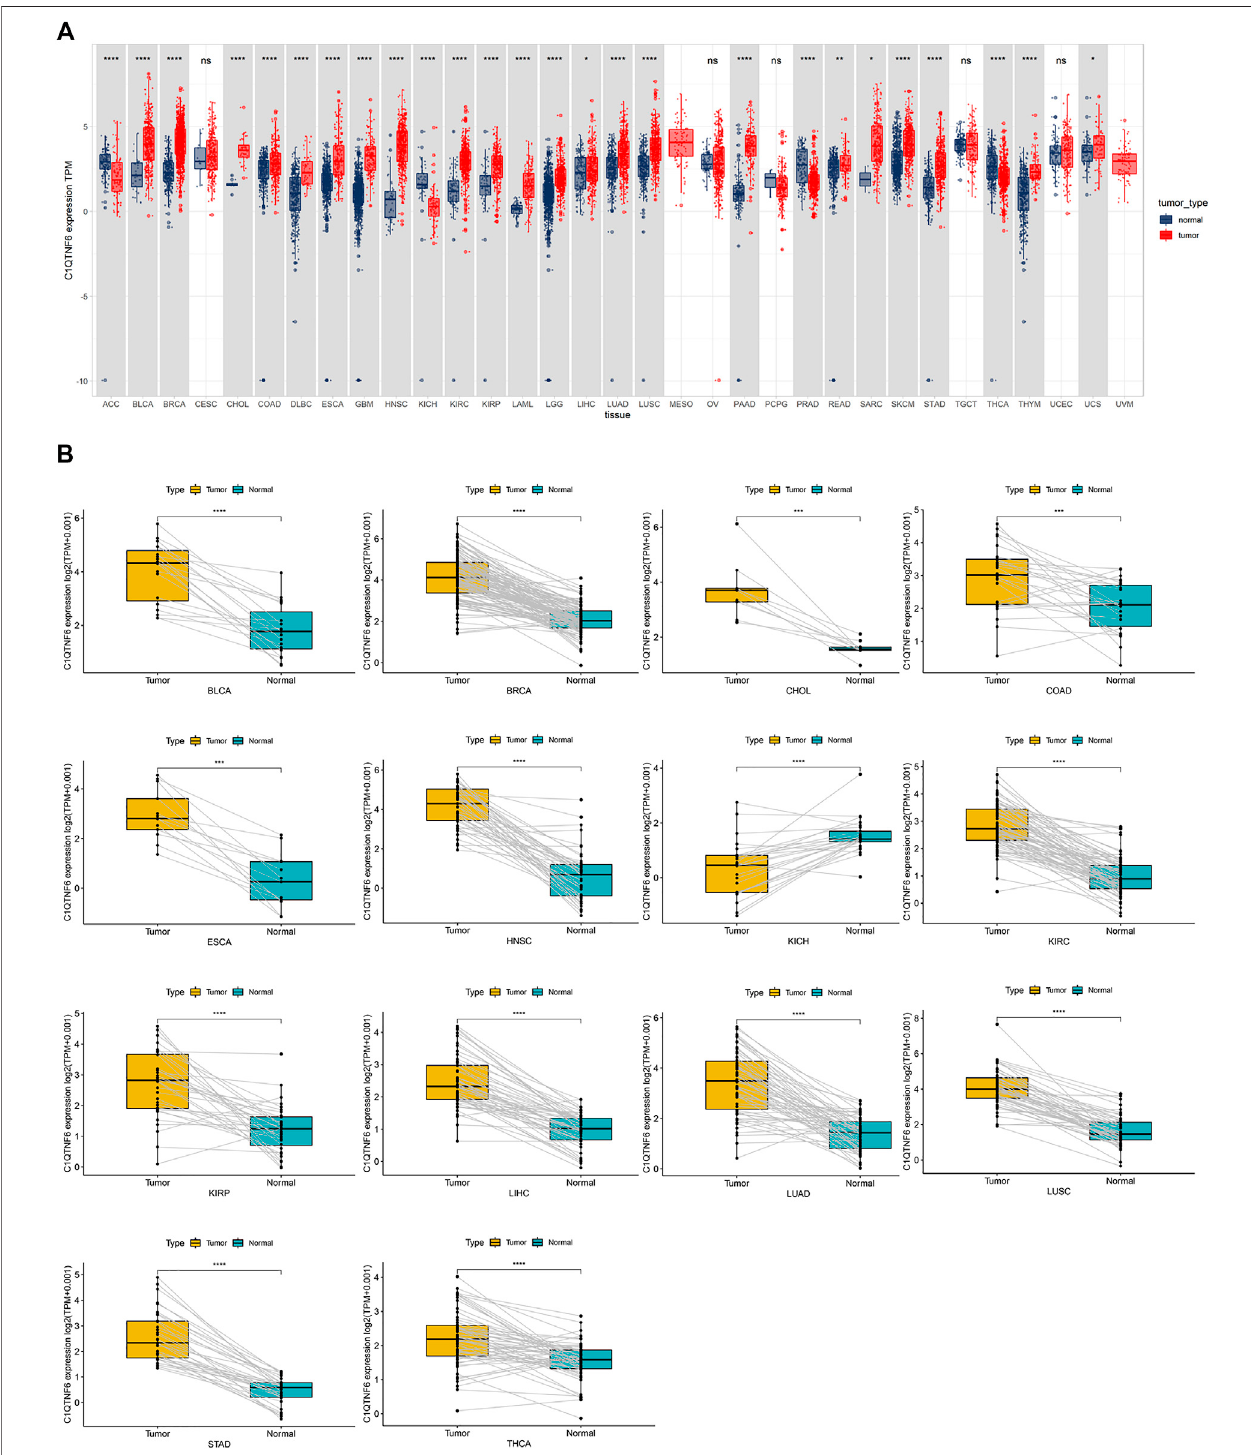
FIGURE 1 | C1QTNF6 pro fi le in pan-cancer. (A) Integrated GTEx database and TCGA database revelation of C1QTNF6 expression across normal and tumor tissues. (B) According totheTCGA data,thelevelsofC1QTNF6 incorresponding tumors andnormaltissues variedacrossvarious cancers.* p < 0.05, ** p < 0.01,*** p < 0.001, **** p < 0.0001.